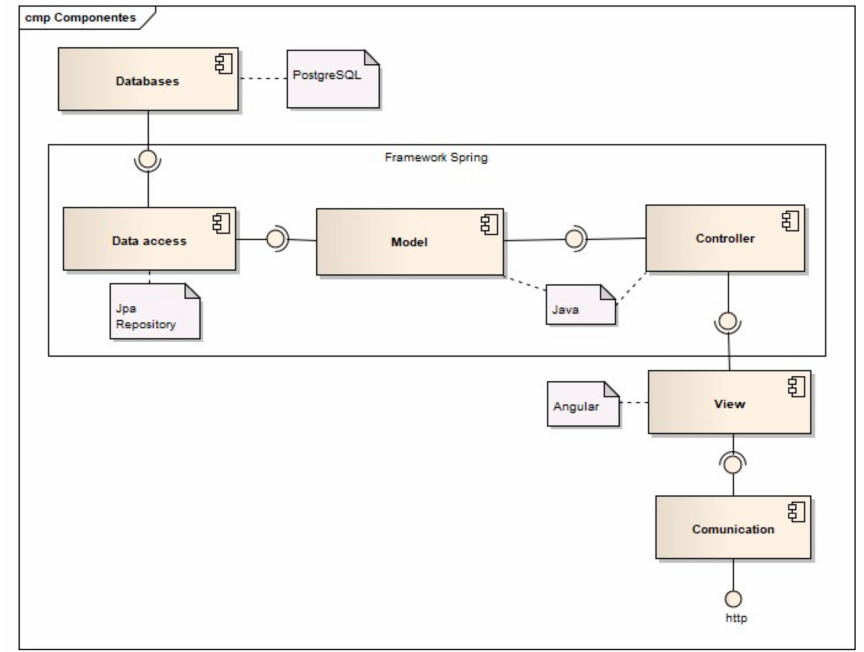
Figure 8. Diagram of system